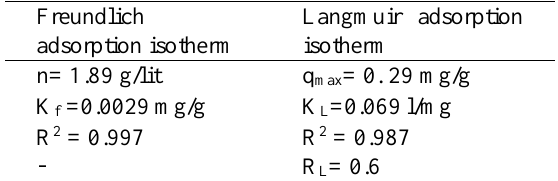
Fig. 2. The removal efficiency in different contact